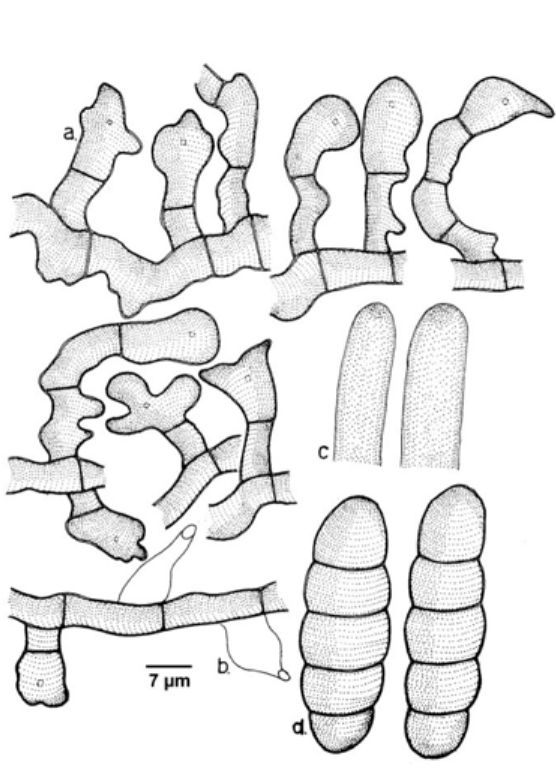
Figure 124. Meliola unonicola a - Appressorium; b - Phialide; c - Apical portion of mycelial setae; d -